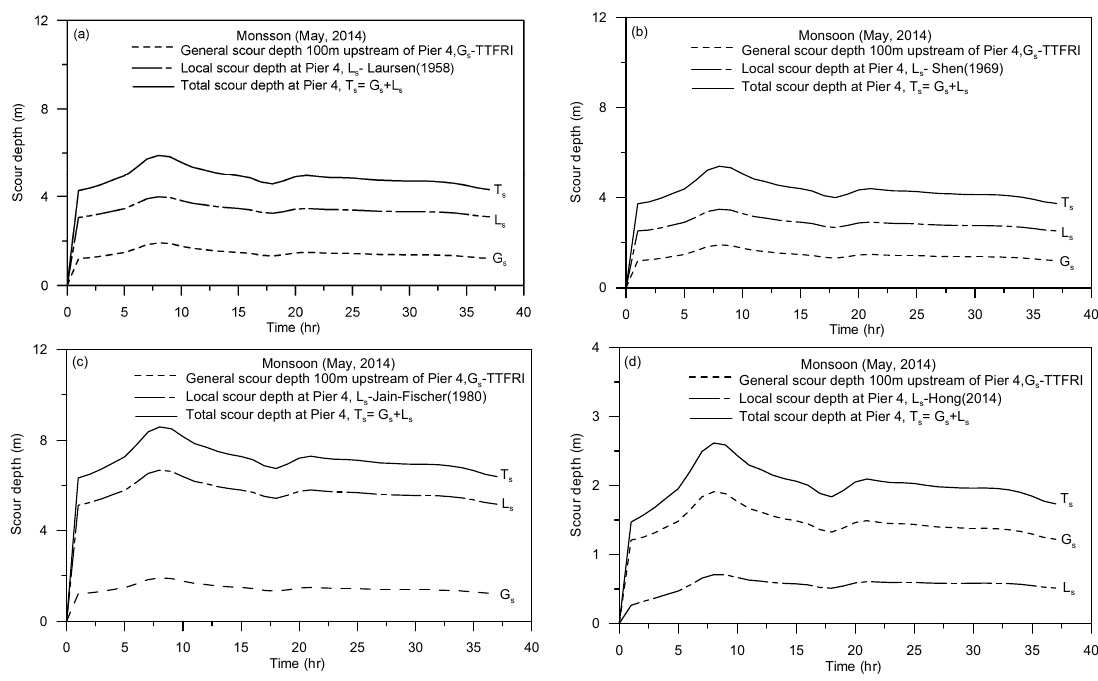
Figure 15. Simulated time variations of scour components during Monsoon (May, 2014).